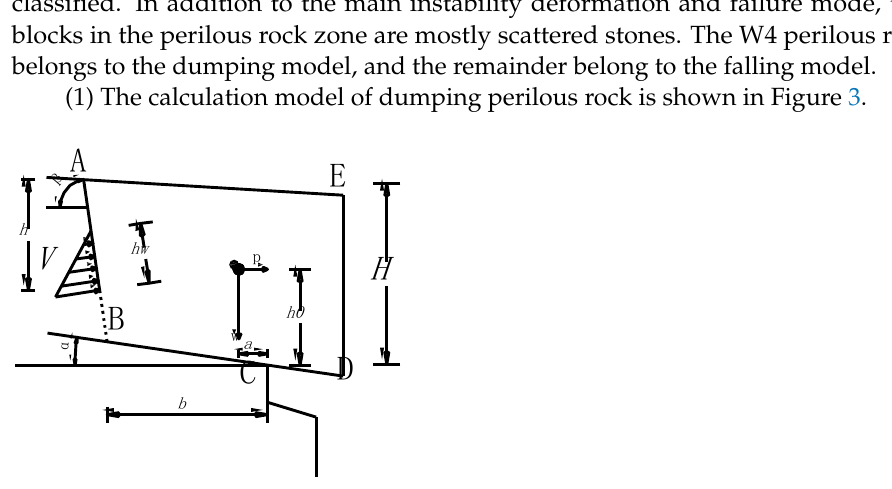
Figure 3. Calculation model of dumping perilous rock.